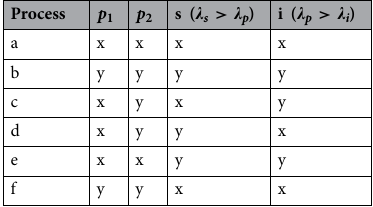
Table 1. List of the SFWM processes related to different polarization combinations of the participating electric fields.